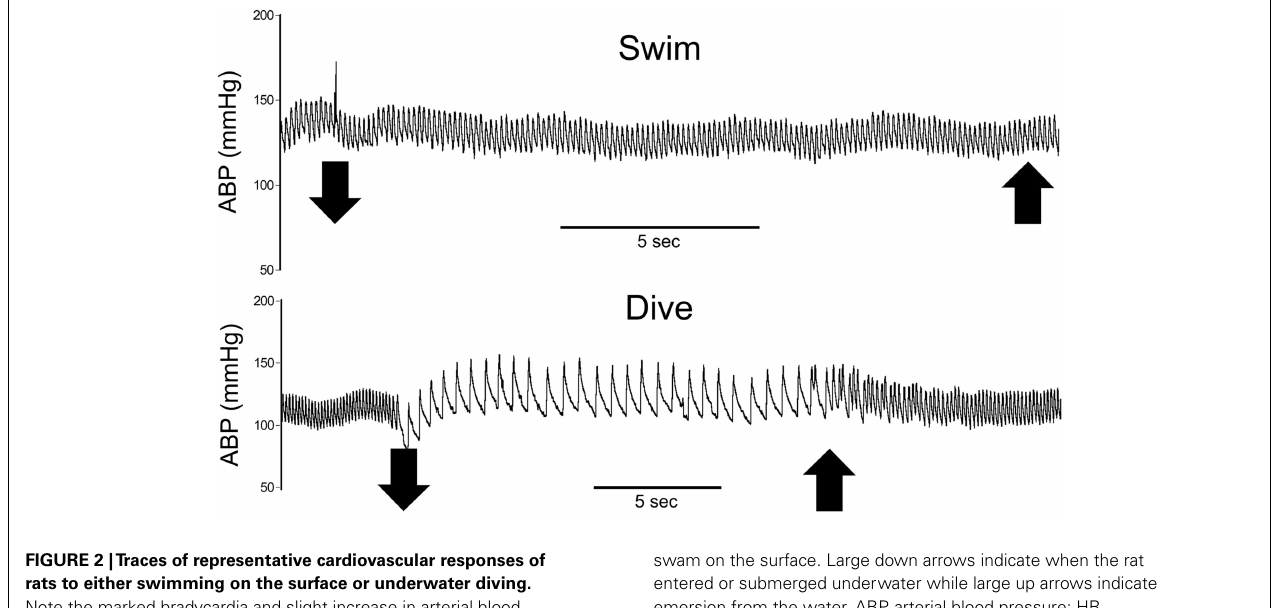
FIGURE 2 |Traces of representative cardiovascular responses of rats to either swimming on the surface or underwater diving. Note the marked bradycardia and slight increase in arterial blood pressure while rats were underwater but no change while rats